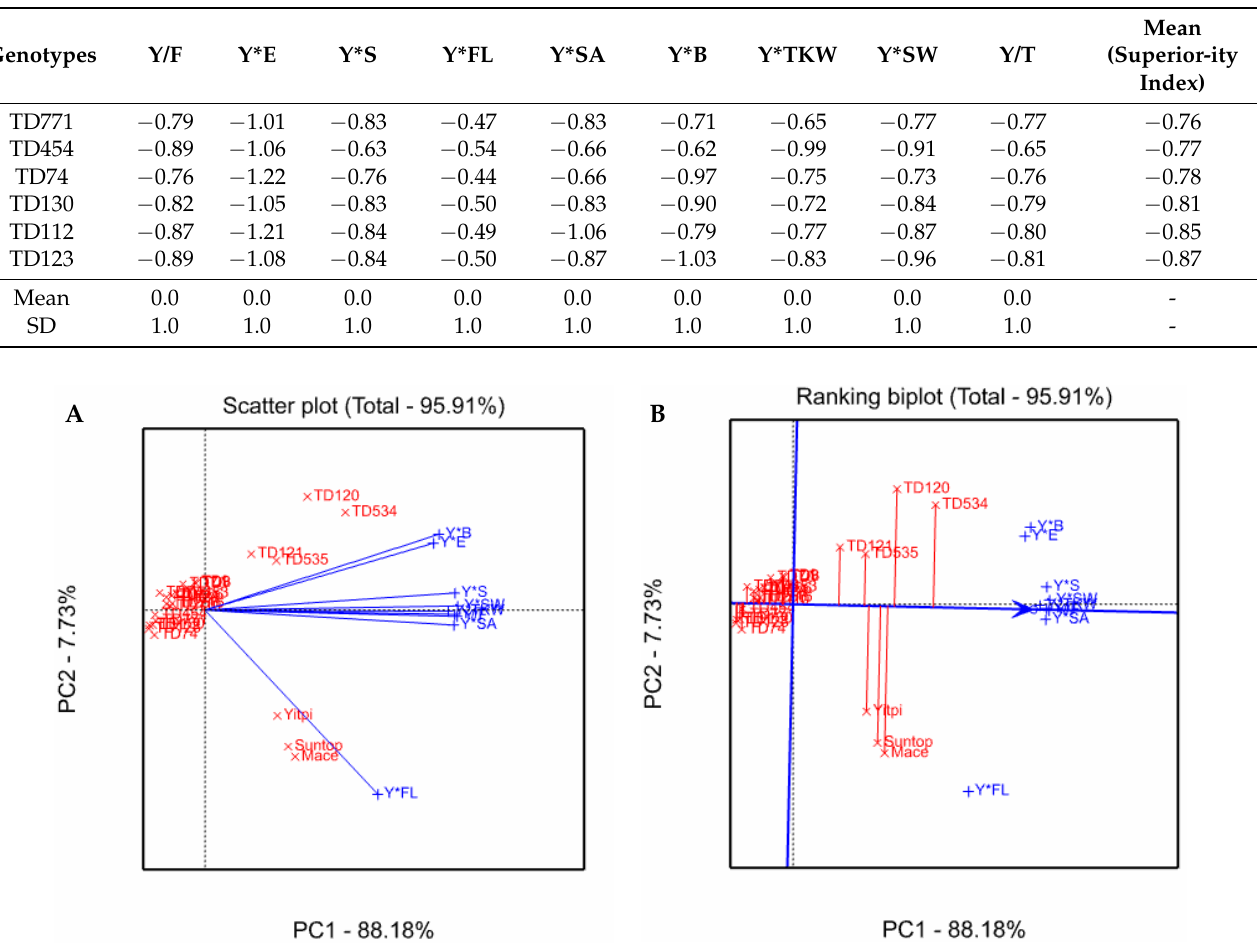
Figure 7. The Tester Vector view ( A ) and the Average Tester Coordinates/ATC view ( B ) of genotype by yield*trait (GYT) biplot showing association among the yield–trait combinations and ranking the genotypes based on the superiority index. The trait codes are Y: Yield; F: Flowering time; E: Effective tiller number; S: Spike length; FL: Flag leaf area; SA: Shoot angle; B: Biomass/plant; TKW: Thousand kernel weight; SW: Seed width, and T: Threshability.